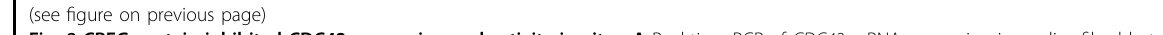
Fig. 8 CREG protein inhibited CDC42 expression and activity in vitro. A Real-time PCR of CDC42 mRNA expression in cardiac fi broblasts with CREG recombinant protein (rCREG, N = 5 per group). B , C Western blotting of CDC42 protein expression in cardiac fi broblasts with rCREG ( N = 5 per group). D Real-time PCR of CREG mRNA expression in cardiac fi broblasts with CDC42 overexpressed-adenovirus (adCDC42, N = 5 per group). E , F Western blotting of CREG protein expression in cardiac fi broblasts with adCDC42 ( N = 5 per group). G Pull-down assay to determine if the effects of rCREG on the CDC42 activity in mouse cardiac fi broblasts under hypoxia ( N = 3 per group). H , I Immunoprecipitation of CDC42 with CREG or CREG with CDC42 in mouse cardiac fi broblasts ( N = 3 per group). J Immuno fl uorescence staining for CREG and CDC42 in cardiac fi broblasts ( N = 3 per group). K , L Western blotting of CREG and CDC42 expression in chloroquine-treated or MG132-treated cardiac fi broblasts. Red indicated CREG expression, green indicated CDC42 expression, blue indicated nuclei, and yellow indicated the co-location of CREG with CDC42 ( N = 5 per group). ** P < 0.01 vs. control or adGFP group; ## P < 0.01, # P < 0.05 vs. rCREG